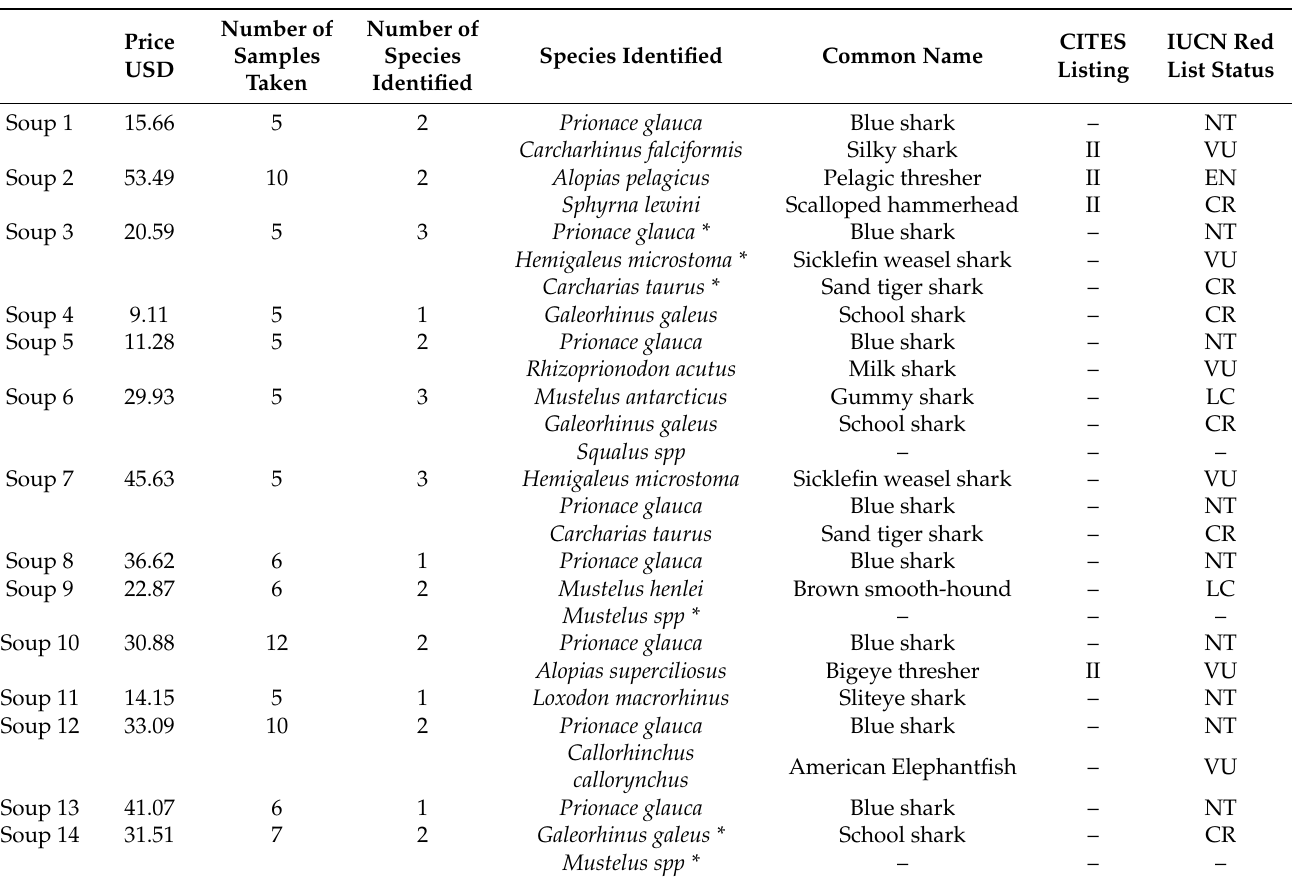
Table 1. Details of the species of sharks in shark fin soups collected in Singapore, their common names and conservation status according to the International Union for Conservation of Nature (IUCN) Red List of Threatened Species and Convention on International Trade in Endangered Species of Wild Fauna and Flora (CITES) listings.